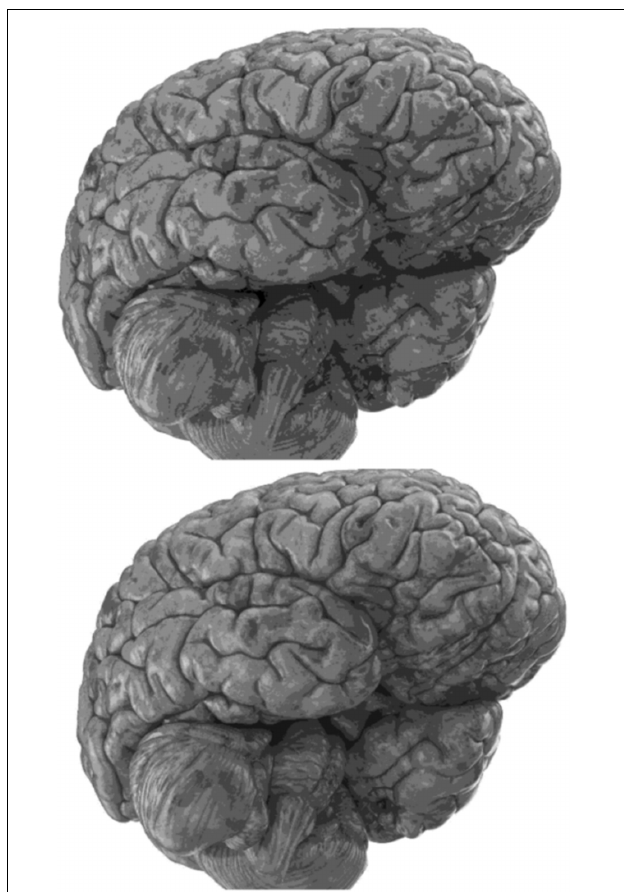
FIGURE 10 | 3D image from the front viewing angle.